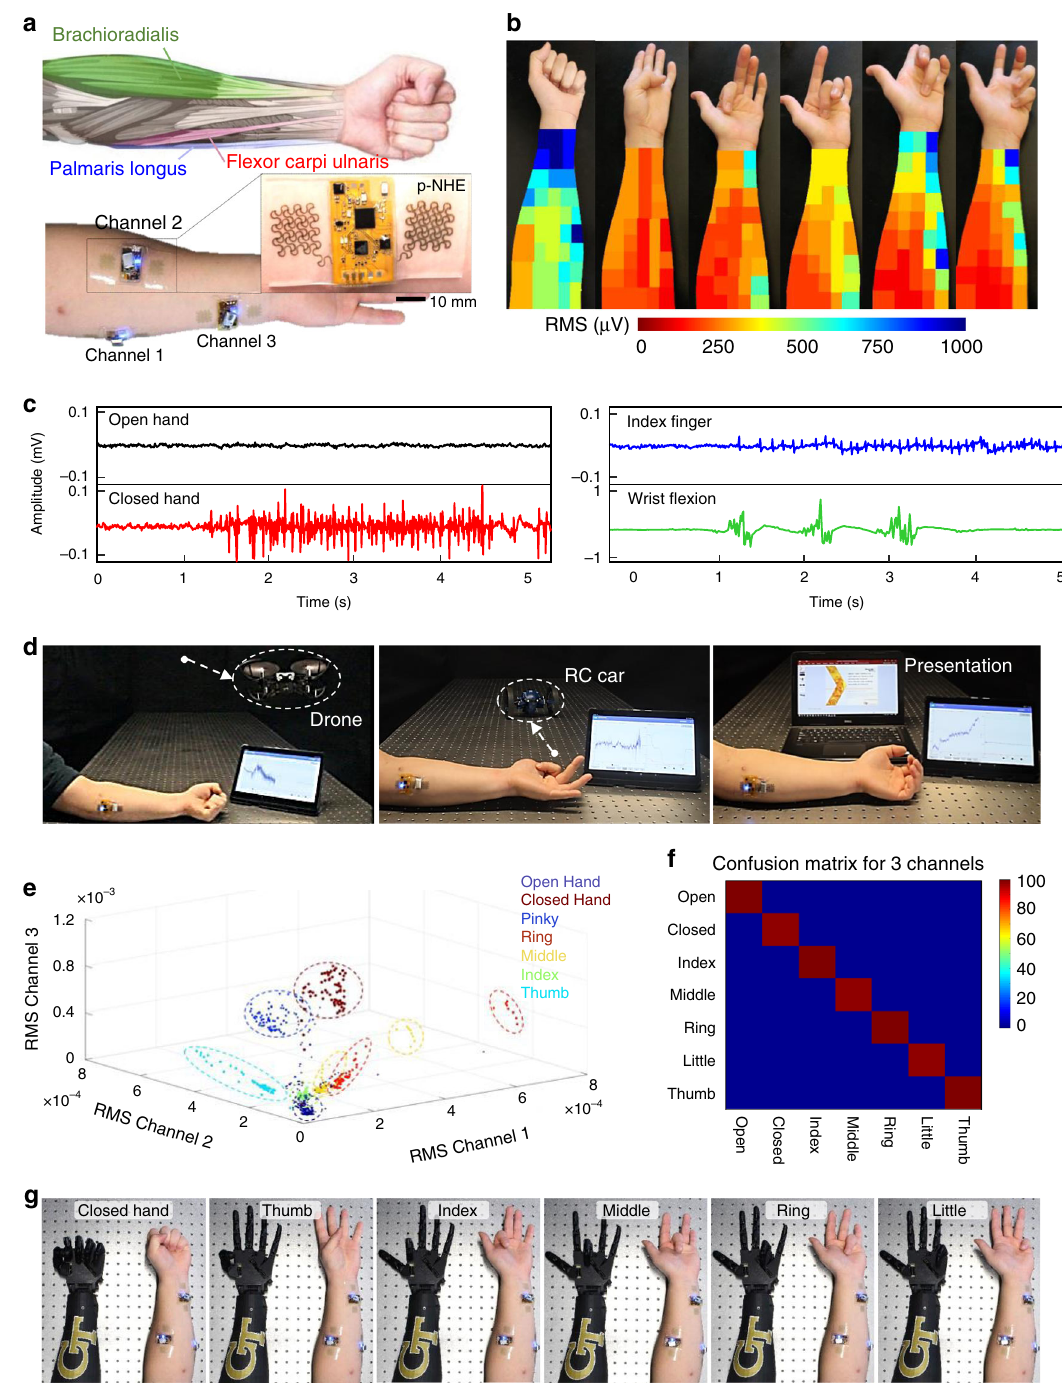
Fig. 4 Demonstration of a wearable p-NHE for wireless, multi-class human-machine interfaces. a Schematic illustration (top) showing target muscles on forearm to recognize multiple gestures and photos (bottom) capturing three p-NHE positioned on targeted muscles, including palmaris longus, brachioradialis, and fl exor carpi ulnaris. Enlarged image shows one of those systems with a circuit and electrodes. b EMG mapping data showing RMS signals from multiple channels that cover the entire forearm; six different heat maps are obtained according to six gestures, including hand closed, thumb, index, middle, ring, and little fi nger motion (from left photo to right photo), for determining the ideal channel locations. c Representative EMG signals from four gestures, including open hand, closed hand (left graphs) and index fi nger fl exion and wrist fl exion (right graphs). d Demonstration of EMG-enabled human-machine interfaces with a wireless, wearable p-NHE to precisely control a fl ying drone (left), RC car (middle), and presentation software (right). In this test, a single-channel device is mounted on the muscle, palmaris longus (shown in a ). e 3D plot of three-channel, EMG RMS signals for clear differentiation of seven different gestures as seven groups. f Summarized result of real-time, confusion matrix from ten trials, showing 98.6% accuracy across seven classes with three-channel EMG recording. g Demonstration of a three-channel EMG recording and corresponding control of a robotic hand, showing examples of six motions of a subject and following motions of the robotic